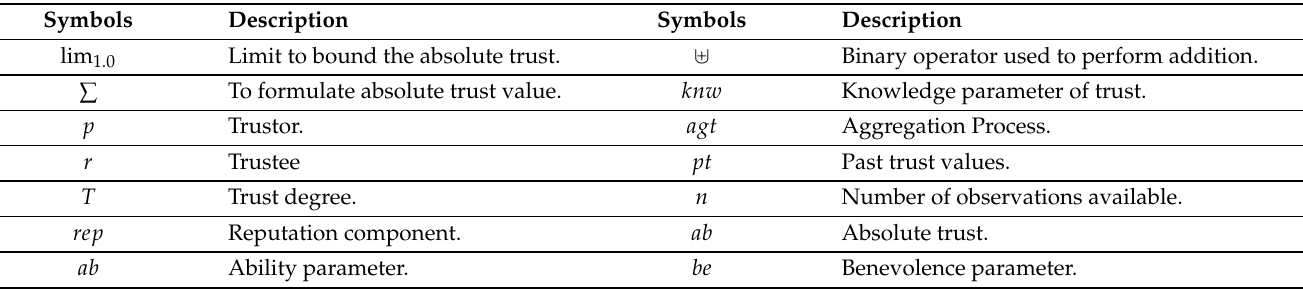
Table 2. Symbols and their